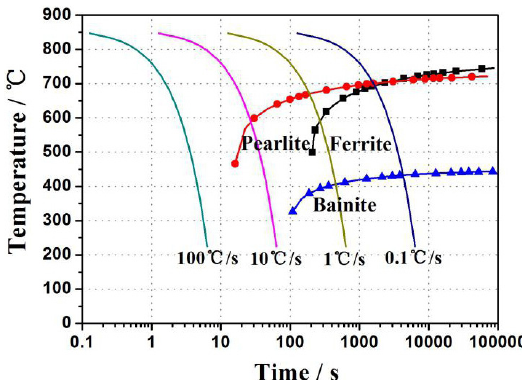
Figure 1. The CCT curve of the tested steel